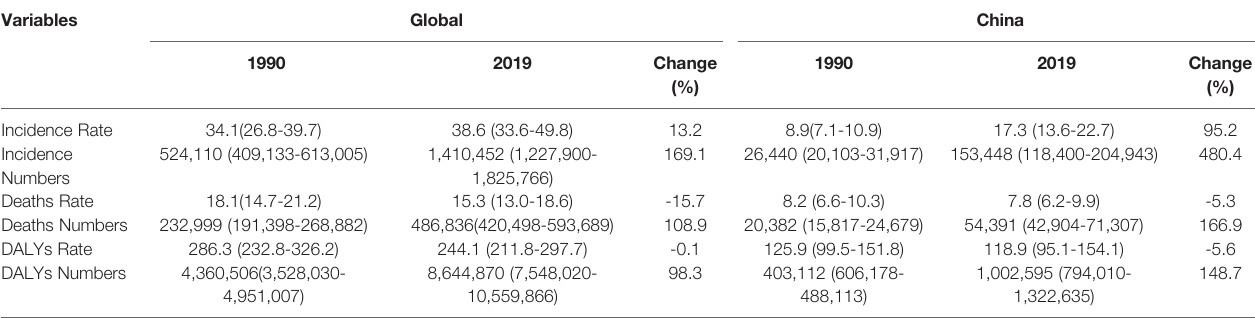
TABLE 1 | The age-standardized rate, numbers and percent change for PC globally and for China, 1990 – 2019.